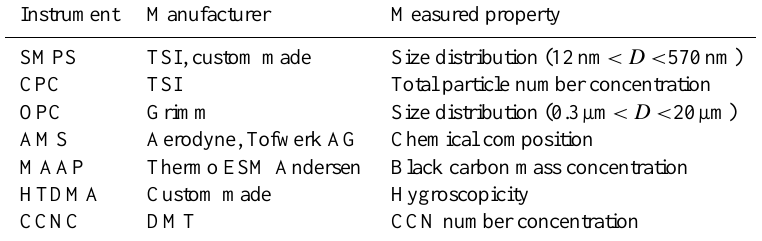
Table 1. The used instrumentation and the measured quantities. For detailed description and for meaning of the abbreviations see text. Instrument